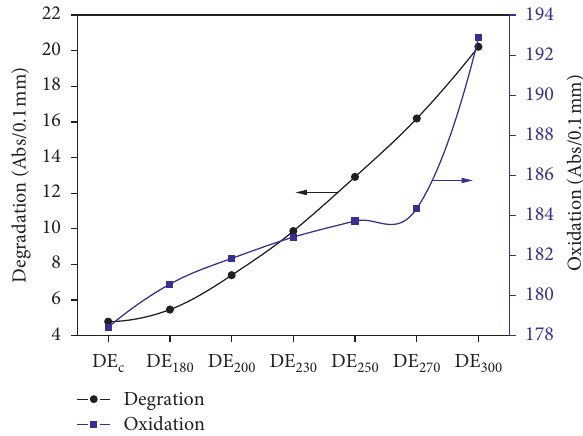
Figure 6: Degradation and oxidation of oil samples.